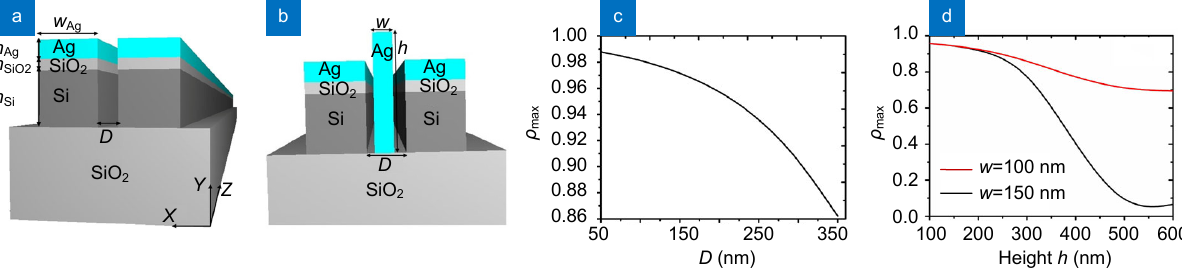
Fig. 5 | Schematic con fi guration of the two parallel hybrid silicon plasmonic waveguides (HSPW) ( a ) without and ( b ) with metallic strip. The maximum power transfer P max versus specific parameters (separation distance D , height h and width w of the metallic strip) ( c ) without and ( d ) with metallic strip 30